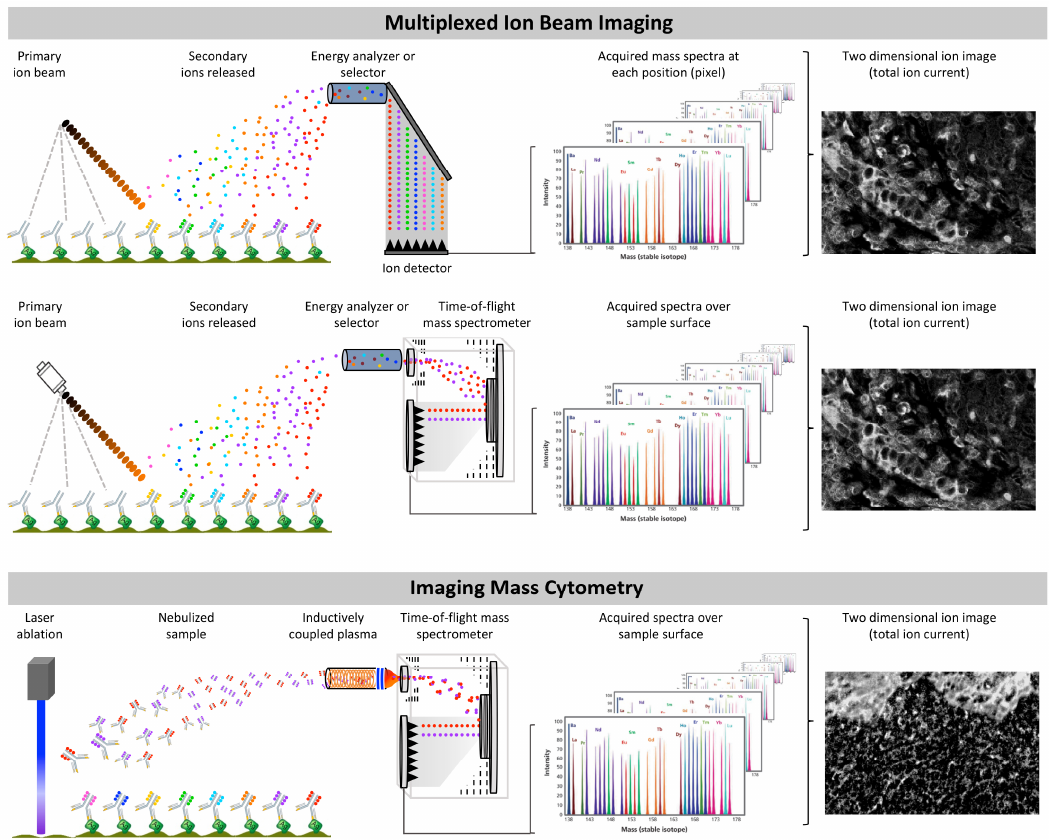
Figure 3. Basic fundamentals and similarities between multiplexed ion beam imaging and imaging mass cytometry. Characterization of multiplexed ion beam imaging and imaging mass cytometry.